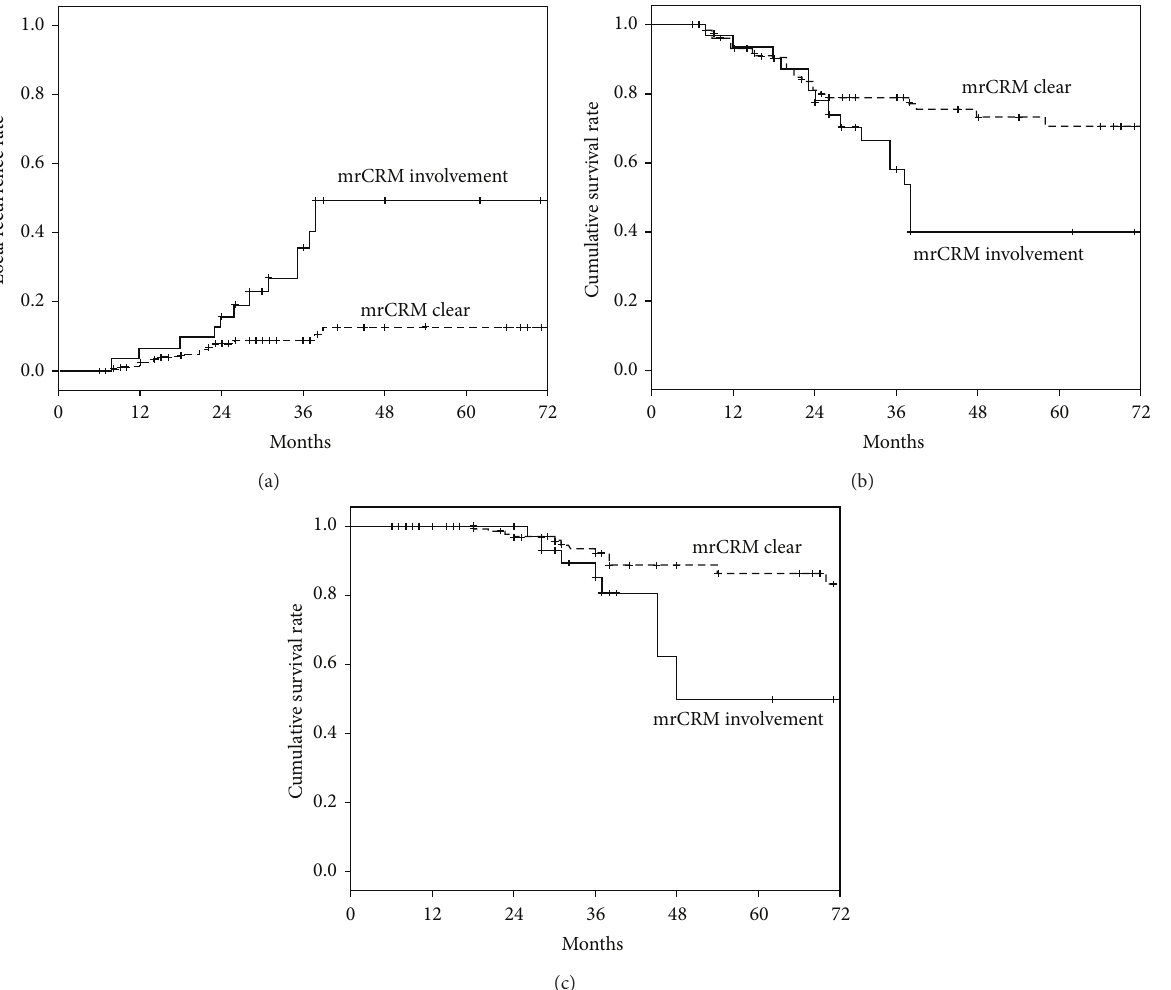
Figure 2: Kaplan-Meier survival plots for time to local recurrence, disease-free survival, and overall survival by circumferential margin status: (a) plot of local recurrence; (b) plot of disease-free survival; (c) plot of overall survival. mrCRM, magnetic resonance imaging-assessed circumferential resection